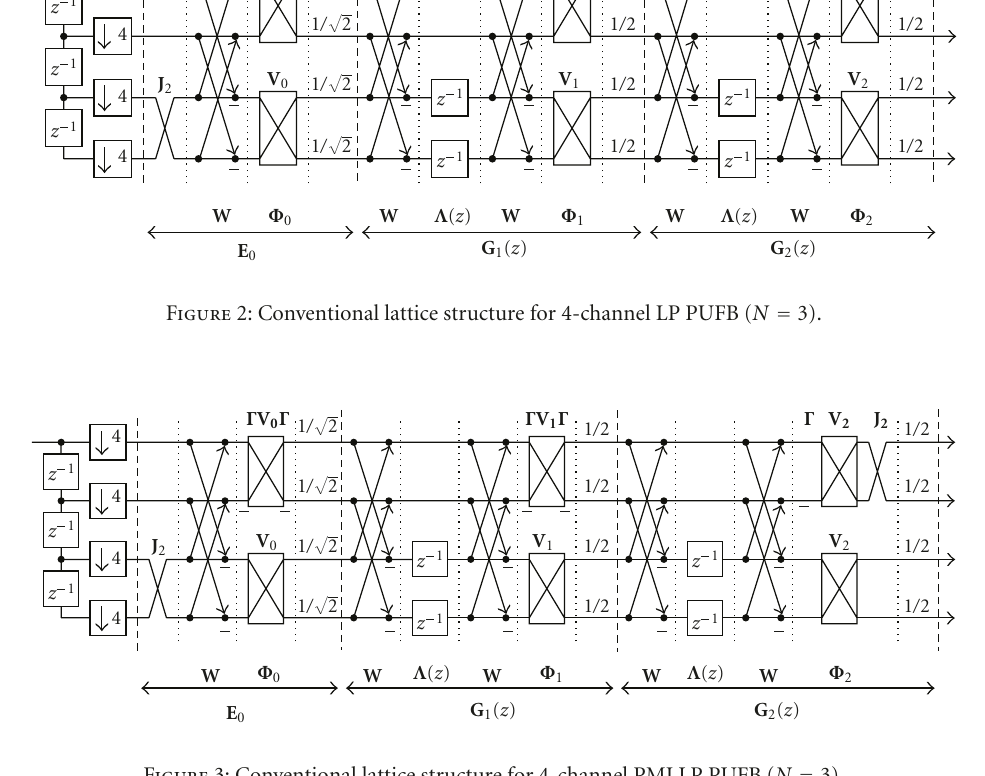
Figure 3: Conventional lattice structure for 4-channel PMI LP PUFB ( N =